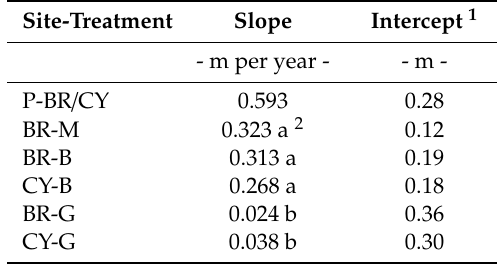
Table 5. Regression equation values for red oak growing in pre-mine native soils (P-BR/CY) and in brown (BR-B and CY-B) and gray mine soils (BR-G and CY-G) at two reclaimed mine sites.